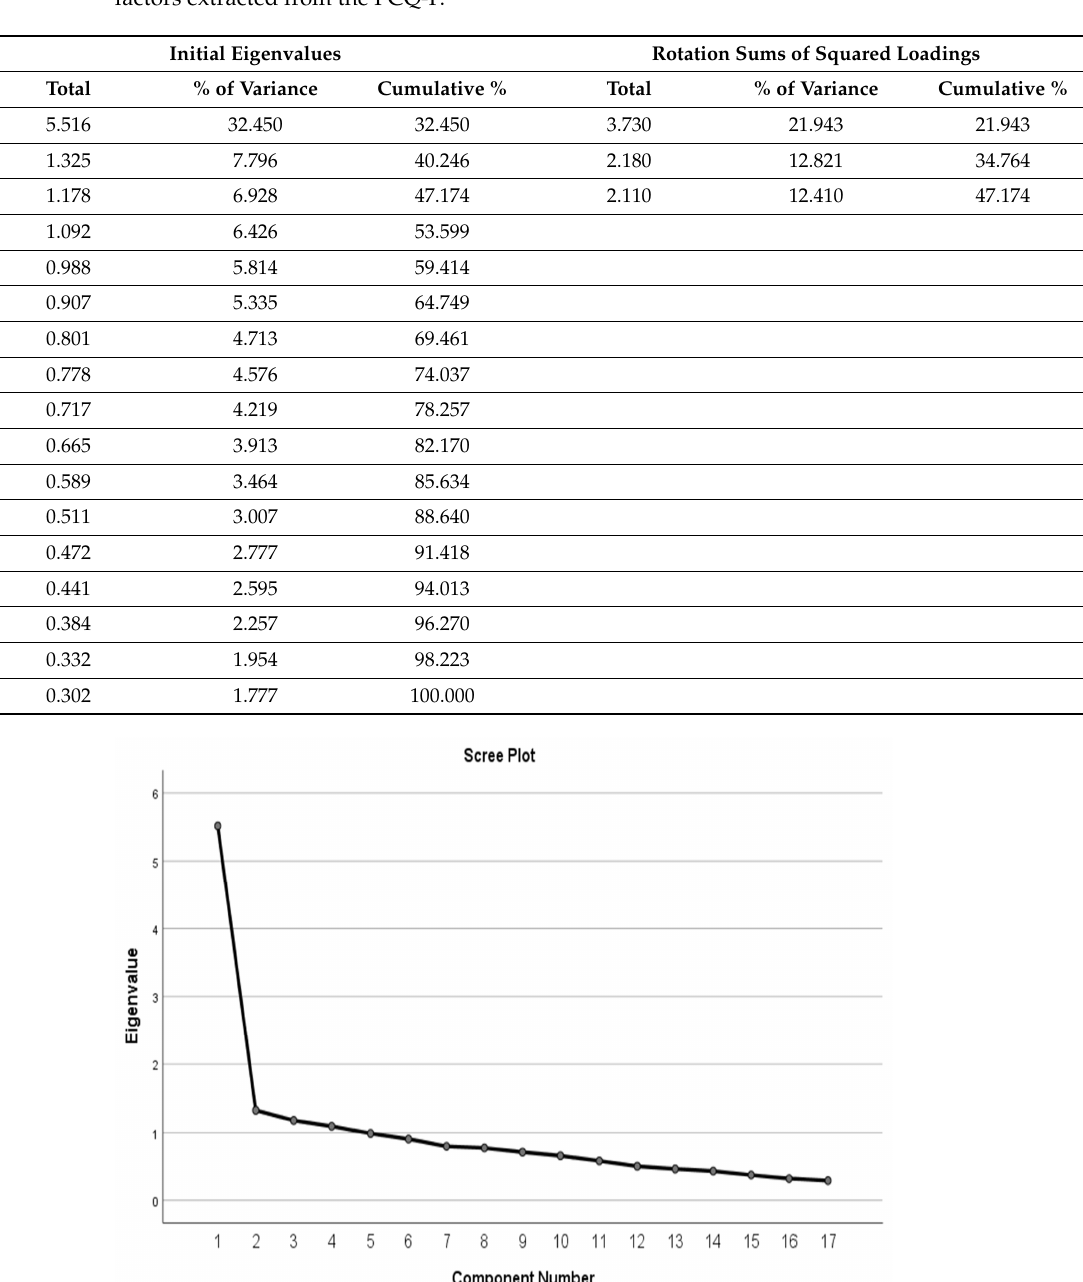
Table 3. Initial Eigenvalues, total variance explained, and cumulative percentage of the three primary factors extracted from the PCQ-P.